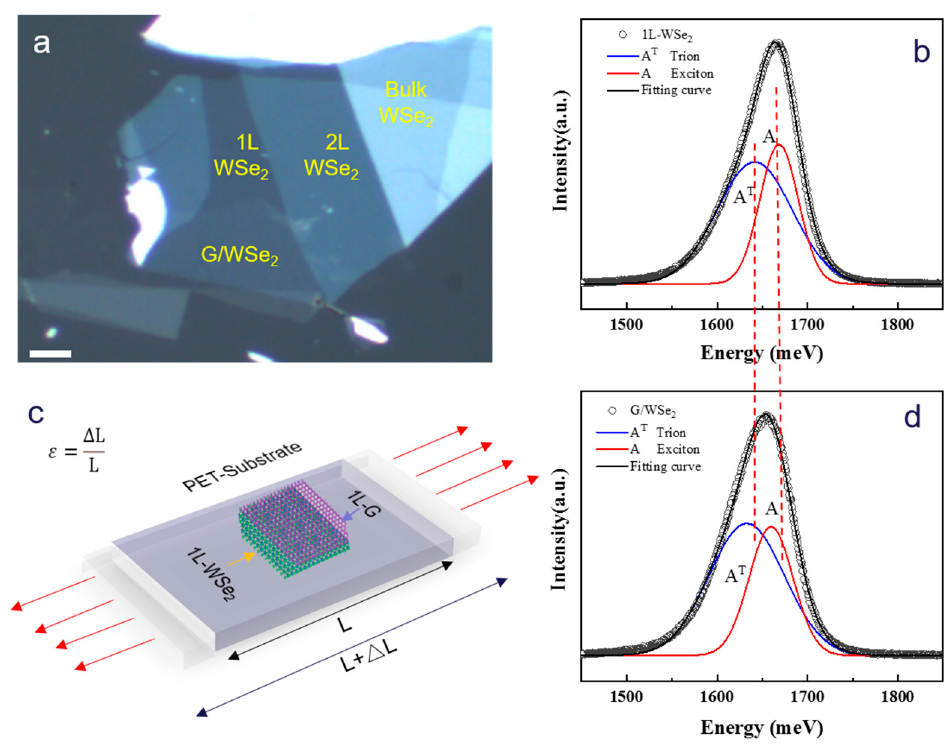
Figure 1. ( a ) Optical image of fabricated monolayer WSe 2 and graphene/WSe 2 heterostructure on PET substrate. The scale bar is 4 μ m. ( b ) PL spectrum with Gauss fitting for 1L WSe 2 . ( c ) Schematic illustration of the uniaxial tensile strain we applied in this work. ( d ) PL spectrum with Gauss fitting for 1L graphene/WSe 2 heterostructure. The red dot line is the eye-guide of clearly read shift for both Exciton A and Trion A T peak in graphene/WSe 2 heterostructure compared to 1L WSe 2 .